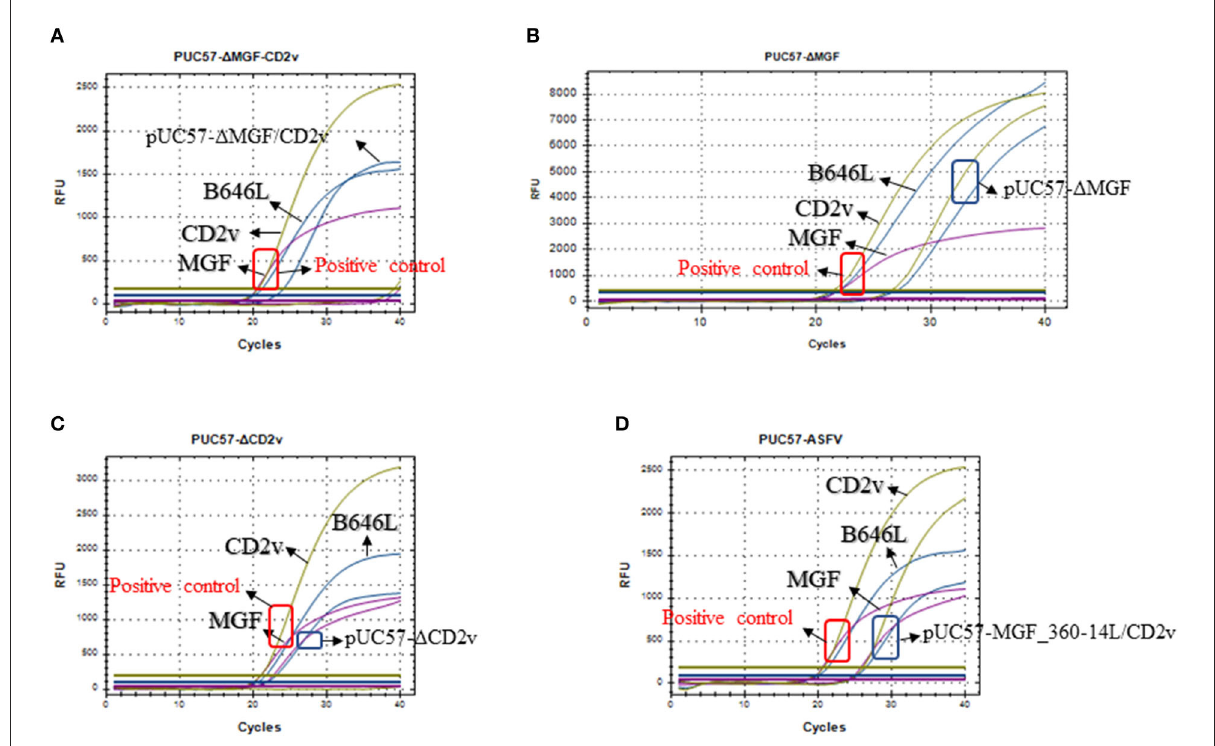
FIGURE4 Detection of the triplex real-time PCR methods developed in this study on the mocks with different gene deletions. (A) Detection of the MGF_360-14L/CD2v double deletion plasmid pUC57- 1 MGF_360-14L/CD2v; (B) Detection of the MGF_360-14L deletion plasmid pUC57- 1 MGF_360-14L; (C) Detection of the CD2v deletion plasmid pUC57- 1 CD2v; (D) Detection of the wild type plasmid pUC57-MGF_360-14L/CD2v; curves in blue represents the amplification curves of B646L; curves in purple represents the amplification curves of MGF_360-14L; curves in glode represents the amplification curves of CD2v. In all panels, a plasmid containing all three genes was used a positive control template gene and the amplification results are shown in red box; while the detection results based on different types of plasmids are shown in blue box.